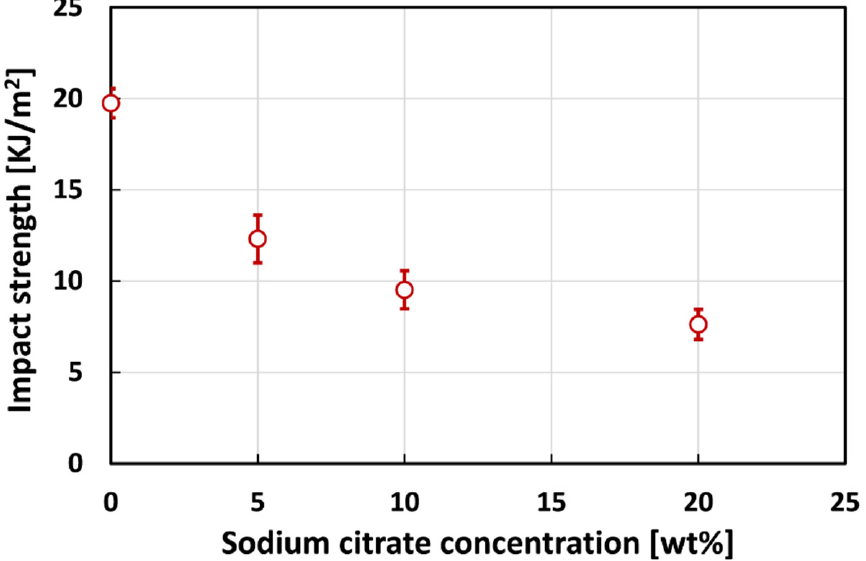
Figure 5. Impact strength of flax fiber reinforced composites at varying the sodium citrate concen- tration.